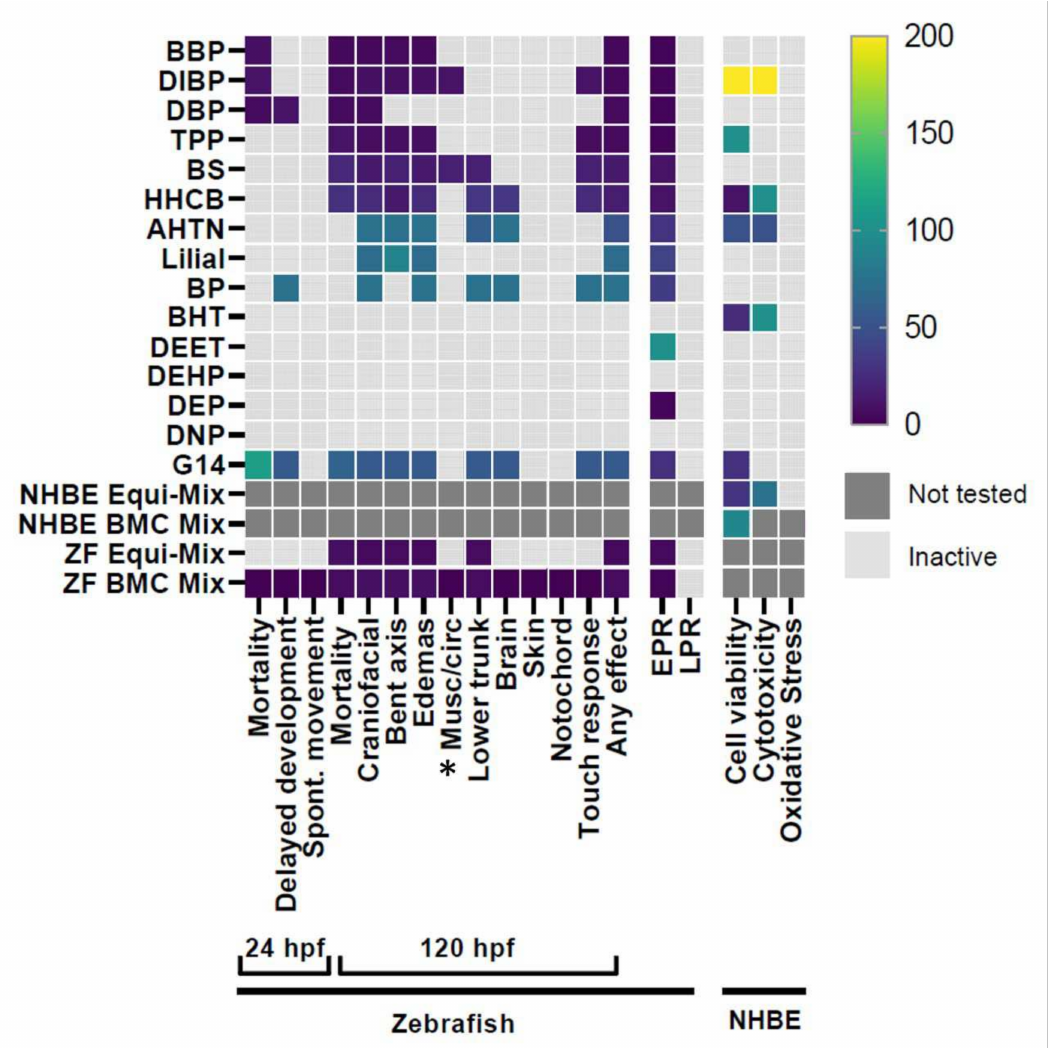
Figure 1. Heatmap of all endpoints across both models for each individual chemical and mixture. Colored boxes represent the lowest concentration to induce a significant effect (LEL) for each endpoint. * = Musc/circ indicates lack of circulation, malformed somites, and/or improper swim bladder formation. LEL values for each endpoint can be found in Table S4.